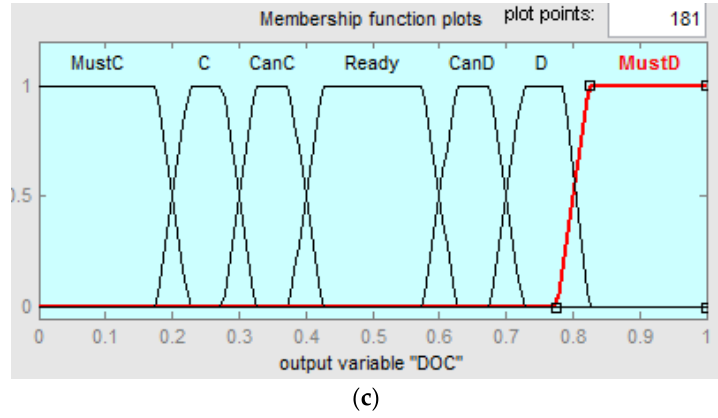
Figure 2. Fuzzy membership function ( a ) state of charge (SOC), ( b ) electricity price, ( c ) decision of charge.